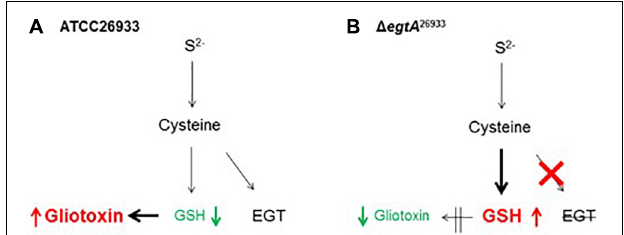
FIGURE 5 | Proposed interaction between EGT, GSH and gliotoxin biosynthesis in A. fumigatus . (A) In A. fumigatus wild-type (ATCC26933), high levels of gliotoxin biosynthesis result in reduced levels of intracellular GSH due to the double glutathiolation step in gliotoxin biosynthesis. This is facilitated by EGT production which compensates for decreased levels of GSH, to maintain cellular redox homeostasis. (B) In (cid:49) egtA 26933 , absence of EGT results in a reduction in antioxidant potential or buffering against ROS, necessitating increased levels of GSH to compensate. GSH is thus diverted from gliotoxin biosynthesis, resulting in decreased levels of